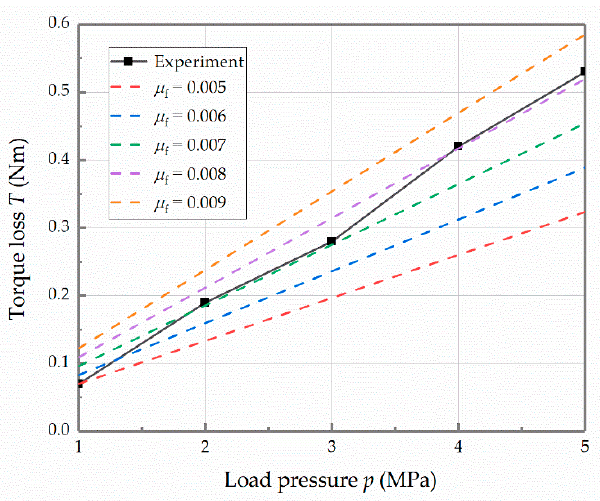
Figure 18. Analytical and experimental torque losses with respect to the load pressure at the rotational speed of 10,000 rpm.